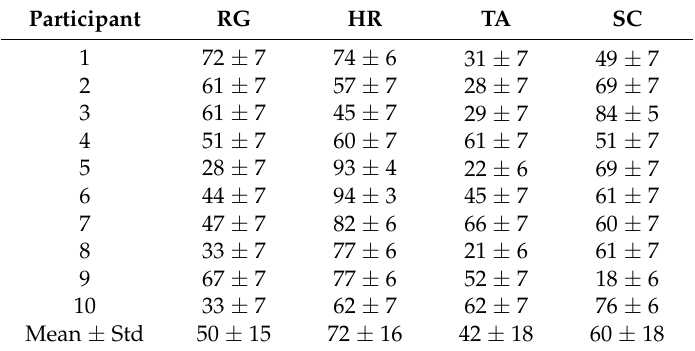
Table 2. Probability of successful detection of stress level using ones stress marker as feature.